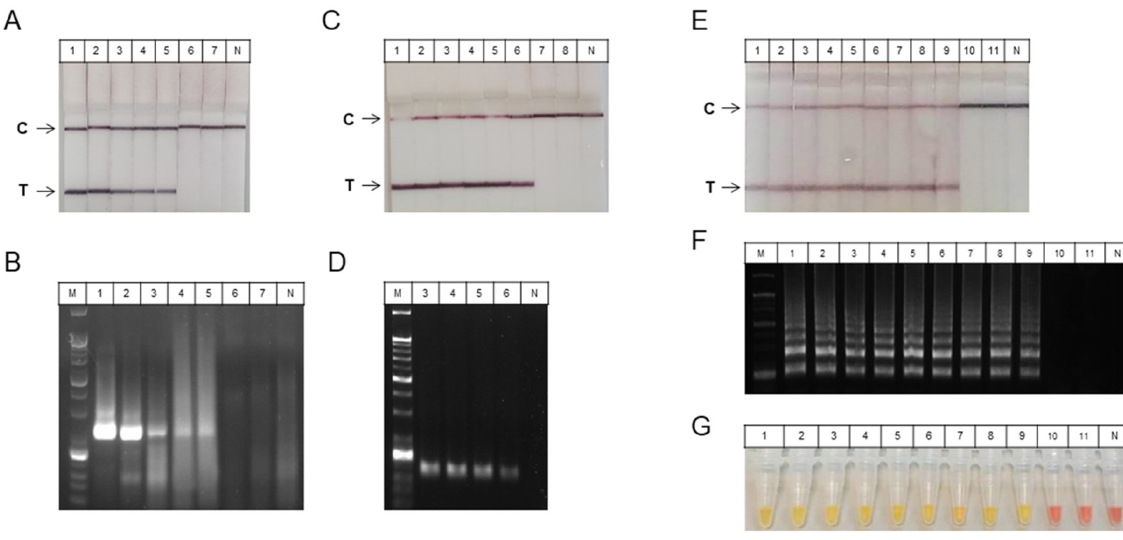
Figure 4. Sensitivities of RT-RPA, RT-HDA, and RT-LAMP assays for SARS-CoV-2 detection. A serial dilution of T7 RNA from the SARS-CoV-2 N gene was used to test the sensitivity of the assay. ( A , B ) The sensitivity of the RT-RPA assay. The RT-RPA reaction products could be detected by the T7 RNA (8.12 × 10 7 to 8.12 × 10 3 per reaction) on a ( A ) LFA and ( B ) 2% agarose gel. The sensitivity was 8.12 × 10 3 of T7 RNA. ( C , D ) The sensitivity of the RT-HDA assay. The RT-HDA reaction products could be detected by the T7 RNA (2.59 × 10 9 to 2.59 × 10 4 per reaction) on a ( C ) LFA and ( D ) 2% agarose gel. Sensitivity was 2.59 × 10 4 of T7 RNA. ( E – G ) The sensitivity of the RT-LAMP assay. The RT-LAMP reaction products visualized the T7 RNA (2.33 × 10 10 to 2.33 × 10 2 per reaction) on a (E) LFA, ( F ) 2% agarose gel, and ( G ) colorimetric RT-LAMP. Sensitivity was 2.33 × 10 2 of T7 RNA. RT, reverse transcription; RPA, recombinase-based polymerase amplification; HDA, helicase-dependent amplification; LAMP, loop-mediated isothermal amplification; N, nucleocapsid; LFA, lateral flow assay; M, size marker; N; negative control; T, target; C, control.